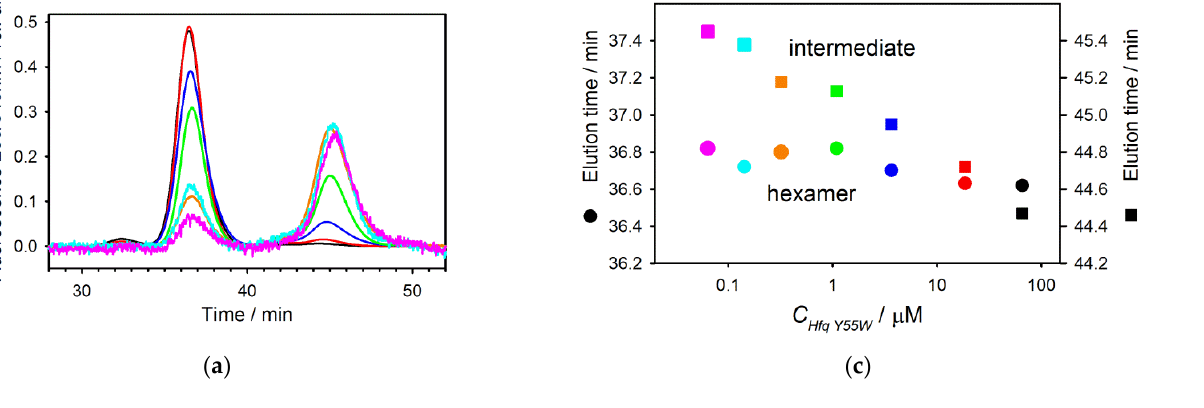
( d ) Figure 6. The size-exclusion chromatography of Hfq Y55W at 1.6 M GuHCl: ( a ) The set of standardized elution profiles of Hfq Y55W at various concentrations of the protein loaded (67 μ M is shown in black, 18.9 μ M—in red, 3.7 μ M—in dark blue, 1.1 μ M—in green, 0.33 μ M—in yellow, 0.15 μ M—in cyan, and 0.064 μ M—in pink); ( b ) The dependence of the elution time on the protein molecular mass (the chromatographic column calibration); proteins used for calibration are aldolase (158 kDa), bovine serum albumin (66 kDa), bovine carbonic anhydrase B (29 kDa), cytochrome c (12.3 kDa). The arrows indicate the elution times of the respective peaks at the highest (black) and the lowest (pink) concentration of the protein loaded; ( c ) The dependence of the elution peak time on the protein concentration loaded ( ◯ —initial peak, ◻ —peak of the dissociated intermediate; the color coding is the same); ( d ) The dependence of the protein state populations (determined as the areas of corresponding elution peaks) on the protein concentration loaded ( ◯ —hexamer, ◻ — dissociated intermediate; color coding is the same). □ ☐ As seen, there are two major and one minor elution peaks. The left minor peak evidently corresponds to some associates and disappears with decreasing protein concentration. The other left major peak shows hexamer elution (Figure 6a,b) and does not change its position with decreasing protein concentration, although its amplitude is diminished (Figure 6a,c). The right peak shows dimer elution (Figure 6a,b) at high protein concentrations, while at low ones, it is close to a monomer (Figure 6b). Similar behavior was reported for the dimeric factor for inversion stimulation [22,33] and may be interpreted as a protein concentration-dependent exchange between the dimeric and monomeric forms of the protein. 2.4. Intermediate Species Accumulated at Low pH The dissociation of hexameric Hfq Y55W occurs at low pH. Figure 7a presents a selected set of Trp fluorescence spectra at various pH, from 6.0 up to 1.4, and a protein (monomer) concentration of 67 μ M. With a pH as low as 4.0, the fluorescence intensity was strongly quenched without a peak shift. By further decreasing pH, the fluorescence intensity increased, and the spectrum exhibited a red shift, achieving the position between